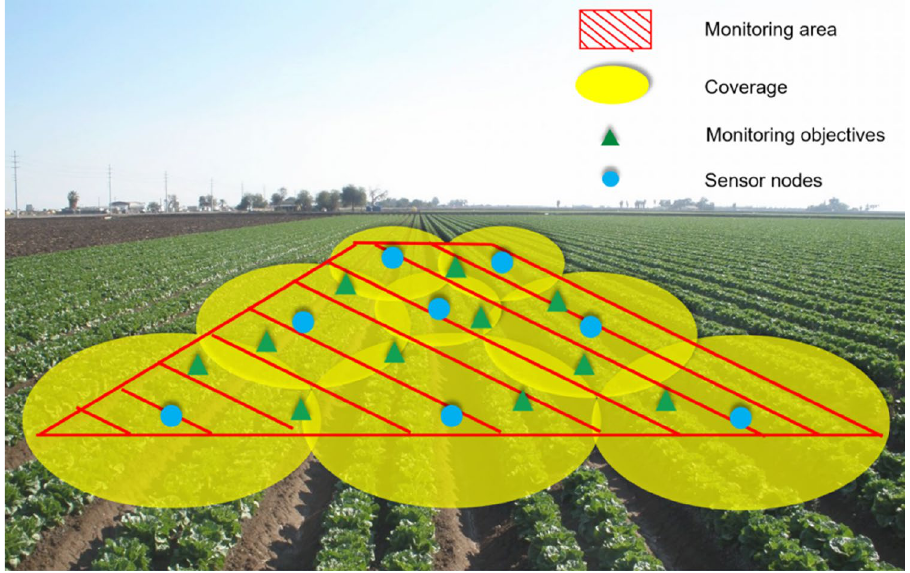
Figure 1. Regional coverage